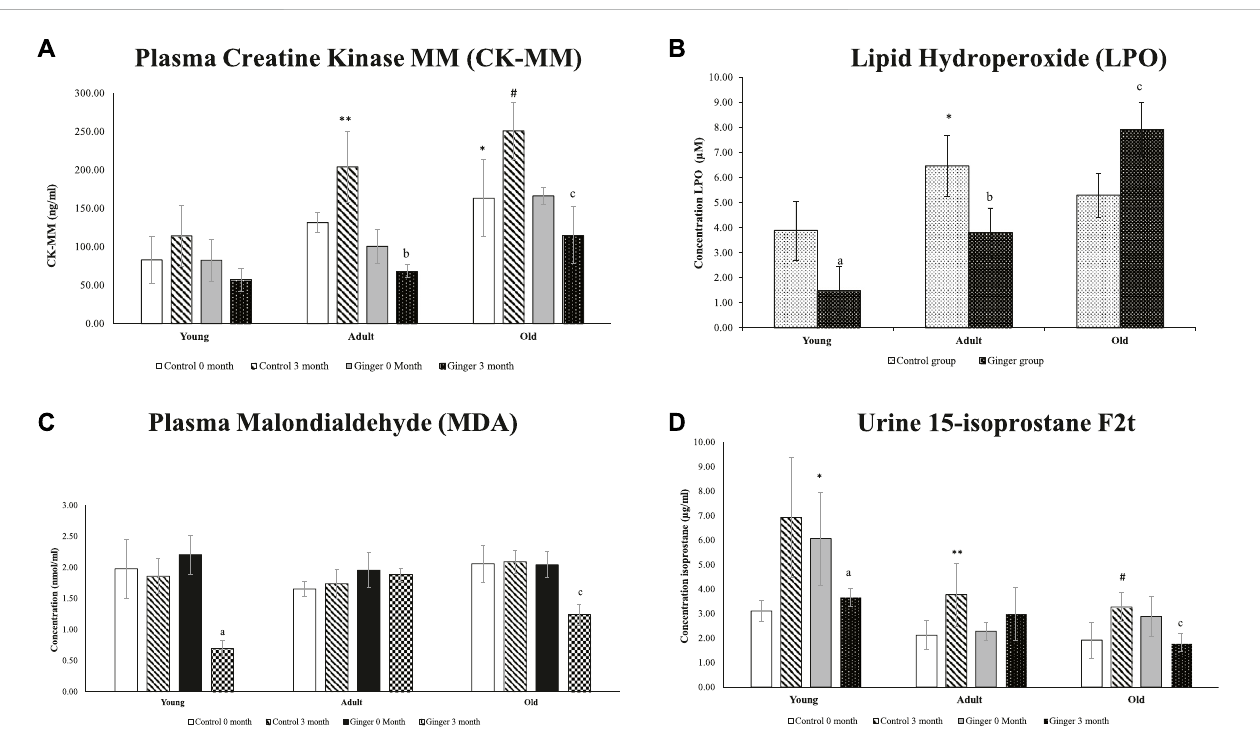
FIGURE 7 Plasma Creatine Kinase MM (CK-MM) (A) , lipid hydroxyperoxide (B) , plasma malondialdehyde (MDA) (C) and urine 15-isoprostane F2t (D) concentrations in young, adult, and old rats. The data were presented as mean ± SD, * p < .05 signi fi cantly different compared to young control rats at 0 month, ** p < .05 signi fi cantly different comparedtoadultcontrolratsat0 month.# p < .05signi fi cantlydifferentcomparedtooldcontrolratsat0month, a p < .05signi fi cantlydifferentcomparedtoyoungginger rats at 0 month, b p < .05 signi fi cantly different compared to adult ginger rats at 0-month, c p < .05 signi fi cantly different compared to old ginger rats on at 0 month.